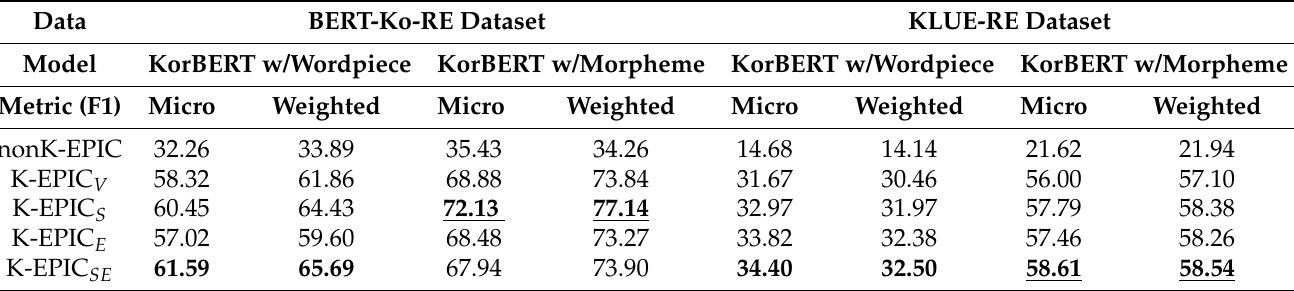
Figure 4. ( a ) Performance on each language model on the BERT-Ko-RE dataset. The green and pink bars indicate the performance of K-EPIC S and K-EPIC SE , respectively; ( b ) performance on each language model on the KLUE-RE dataset. The green and pink bars indicate the performance of K-EPIC S and K-EPIC SE , respectively. Table 6. Experimental results between different tokenizers on KorBERT. Underlined text denotes the highest score of the KorBERT with a morpheme-based tokenizer and bold text indicates the highest score among the methods of utilizing